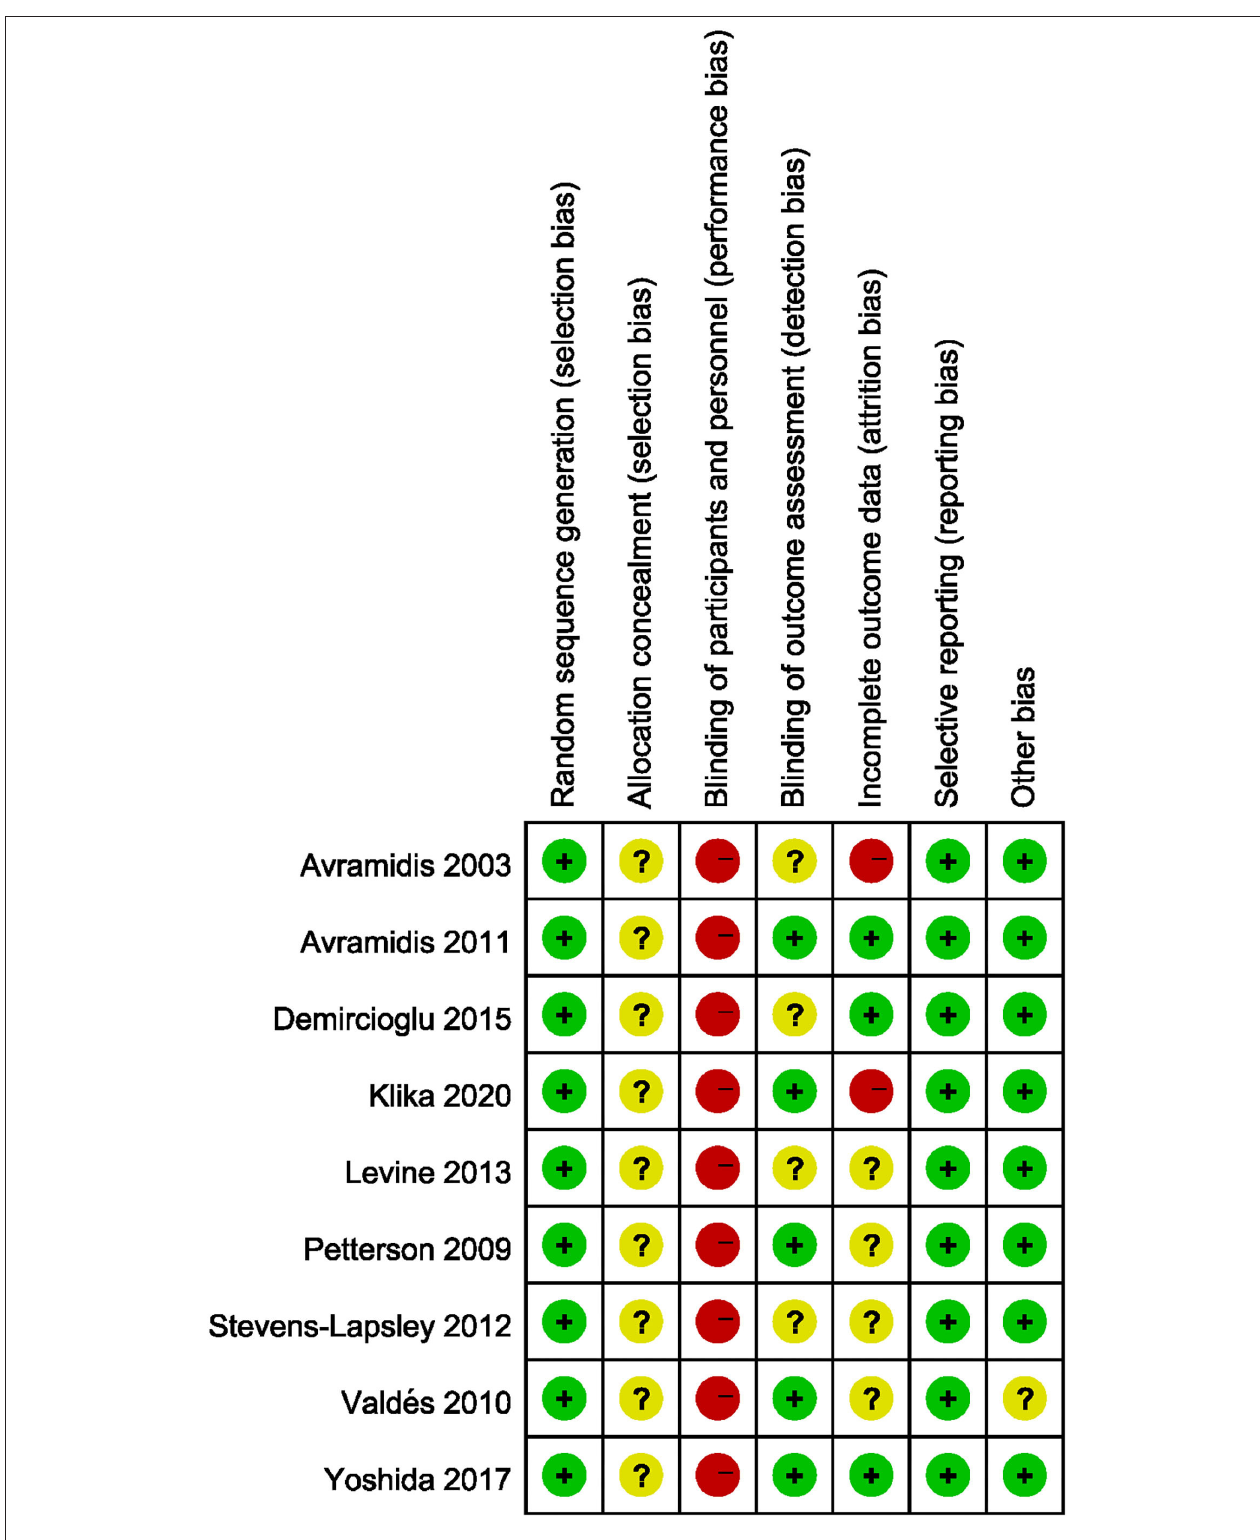
FIGURE 3 | Risk of bias summary for each included studies.